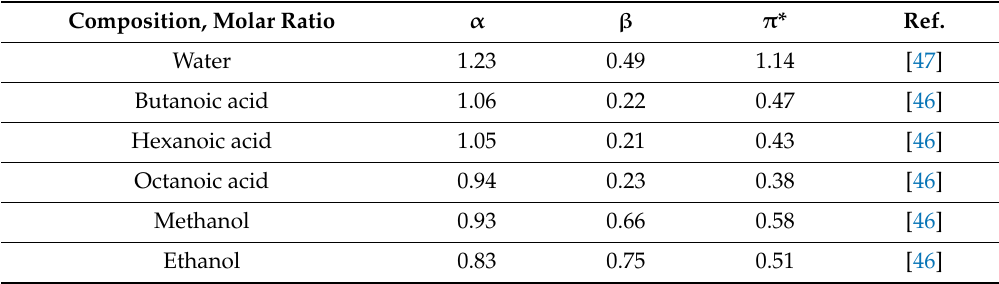
Table 4. Kamlet-Taft parameters of water, organic compounds and DESs, in di ff erent molar ratios, using a set of probes: a (N,N-diethyl-4-nitroaniline, 4-nitroaniline and pyridine-N-oxide); b